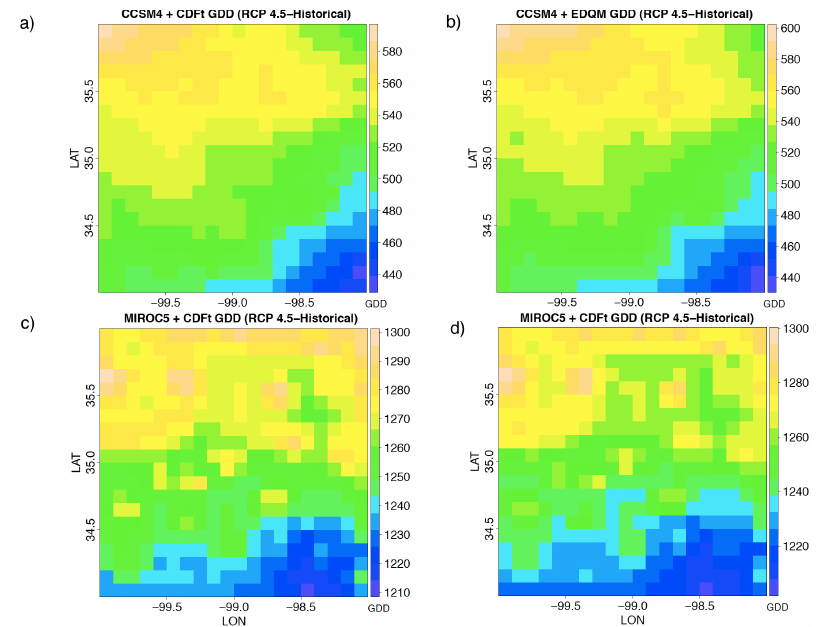
Figure 8. Mean differences between the outputs of the historical period (1961–2004) and the future period (2006–2098)—RCP 4.5 simulation. ( a ) outputs for the CCSM4 GCM and CDFt downscaling method. ( b ) outputs for the CCSM4 GCM and EDQM downscaling method. ( c ) outputs for the MIROC5 GCM and CDFt downscaling method. ( d ) the outputs for the MIROC5 GCM and EDQM downscaling method.